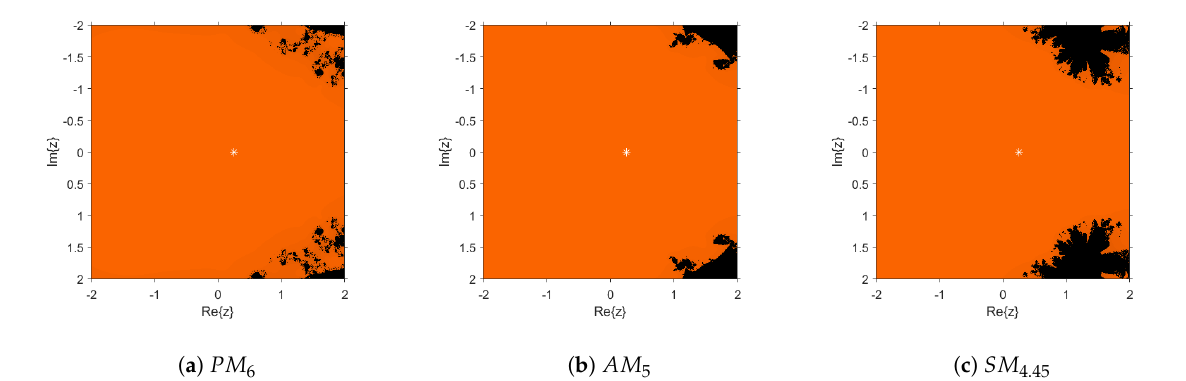
Figure 5. Complex dynamical planes of new and known methods on z 2 − exp ( z ) − 3 z + 2, with ξ ≈